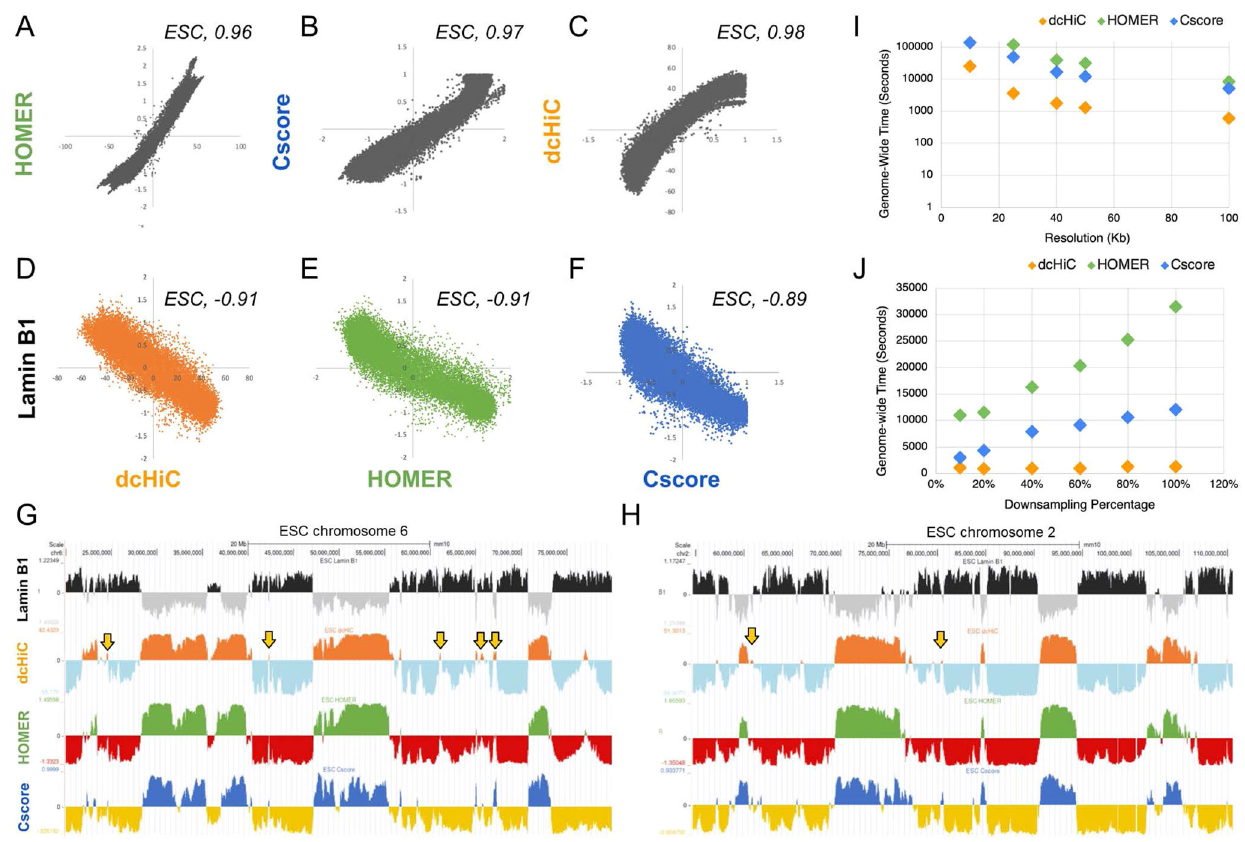
Fig. 2 | Comparison of dcHiC compartment scores with HOMER compartment scores and Lamin B1 association data. A – C Genome-wide comparison of dcHiC (orange), HOMER (green), and Cscore (blue) compartment scores against each other for mouse ESCs. D – F Genome-wide comparison of dcHiC, HOMER, and Cscore compartment scores against Lamin B1 pro fi les for mouse